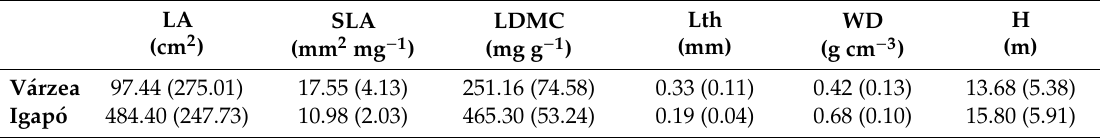
Table 3. Community weighted mean (CWM) trait values ( ± standard deviation) according to forest type (v á rzea and igap ó ) for leaf area (LA), specific leaf area (SLA), leaf dry matter content (LDMC), leaf thickness (Lth), wood density (WD), and plant height